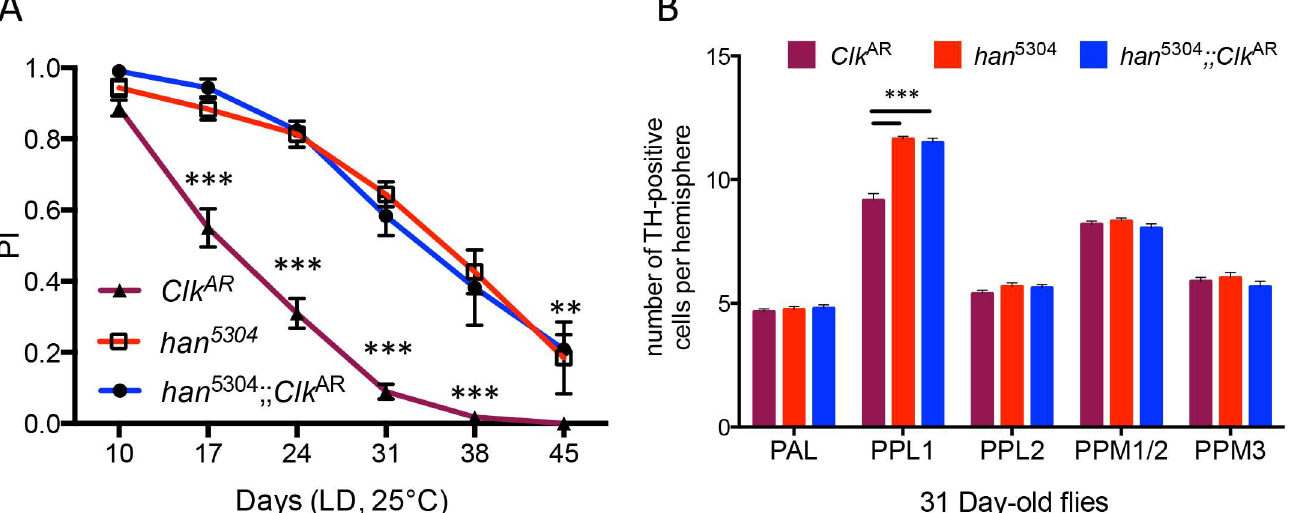
Fig 6. Clk AR locomotor and neuronal phenotypes require the PDF receptor. (A) ARLI was assayed in the Clk AR and han 5304 mutants, and in the han 5304 ;; Clk AR doublemutant. The latter did not show the accelerated ARLI characteristic of Clk AR flies. The graph displaysthe means ± SEM from 2 independent experiments. (B) Histogramsdisplay the mean ± SEM of TH-IR cell numbersin the PAL, PPL1, PPL2, PPM1/2 and PPM 3 clusters, from 2 independentexperiments with 7–8 brains per genotypein each experiment. At 31 days of age, no TH-IR cell loss was observedin either han 5304 or han 5304 ;; Clk AR , contrary to the loss of TH-IR cells in the PPL1 cluster characteristic of aged Clk AR flies.